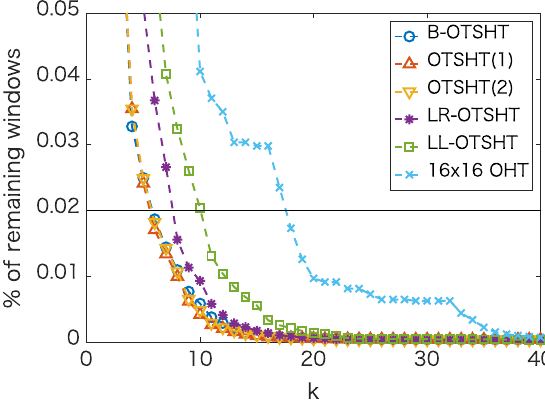
Figure 9. Percentage of remaining windows after pruning that is conducted every k -th basis